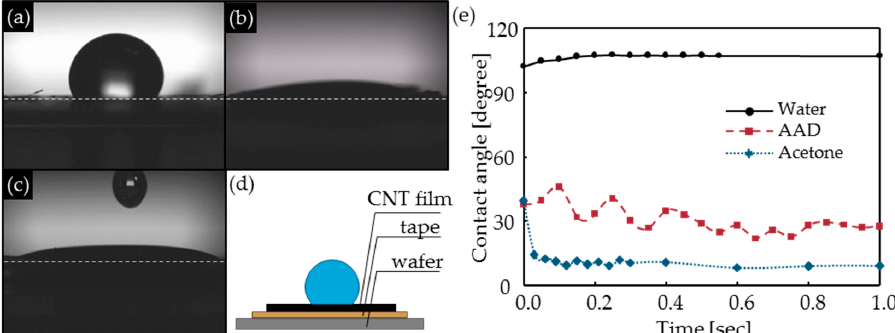
Figure 4. The contact angle to the CNT films of liquid: ( a ) water, ( b ) acetone, and ( c ) azelaic acid dichloride (AAD). ( d ) Schematic diagram of contact angle measurements method. ( e ) The contact angle of liquids vs. time. Slow-motion videos available (Supporting materials). Table 2. The surface tension at 25 °C and 1 atm, and the contact angle to the CNT films of three solvents.